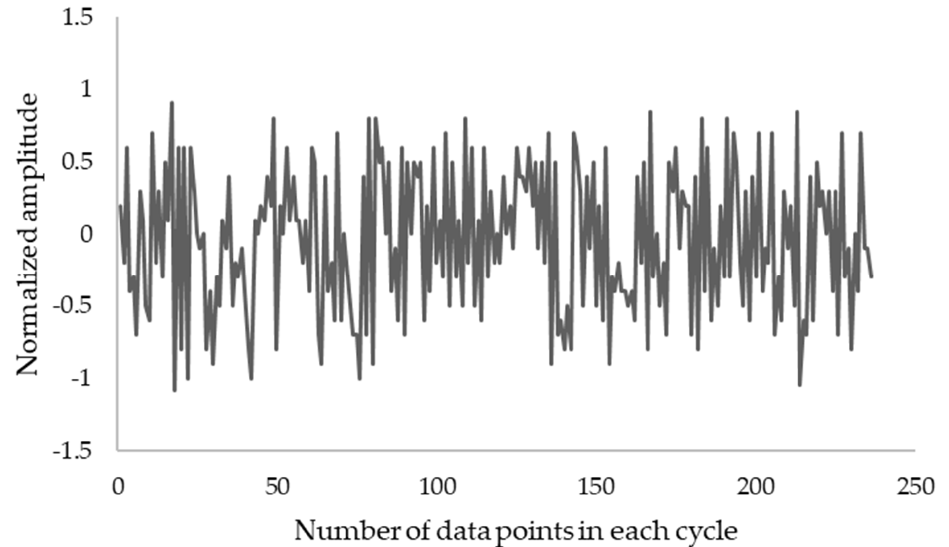
Figure 7. Flight loading spectrum for each fatigue cycle. The bond stat plot (crack propagation plot) output in ABAQUS represents the fatigue crack propagation. The blue color represents the unbonded region, while the red color represents the bonded region. Figure 8 represents the BDSTAT plot for the tail wing structure. The BDSTAT plot was computed between the upper skin and the middle rib of the composite structure.